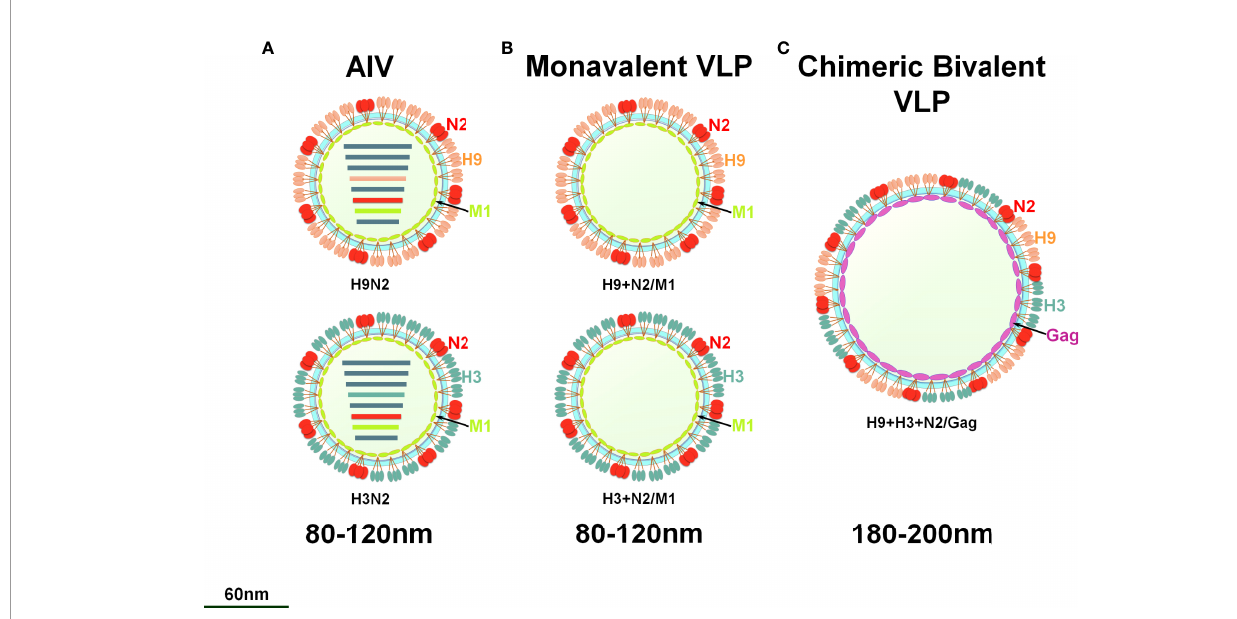
FIGURE 2 | A schematic diagram of monovalent VLPs and bivalent chimeric bivalent VLP. (A) A sketch illustrates H9N2 or H3N2 subtypes of AIV; (B) Monovalent H9N2 or H3N2 VLPs with HA, NA and M1 genes; (C) Chimeric bivalent VLPs co-localizing H9, H3 and N2 into the Gag of BIV.